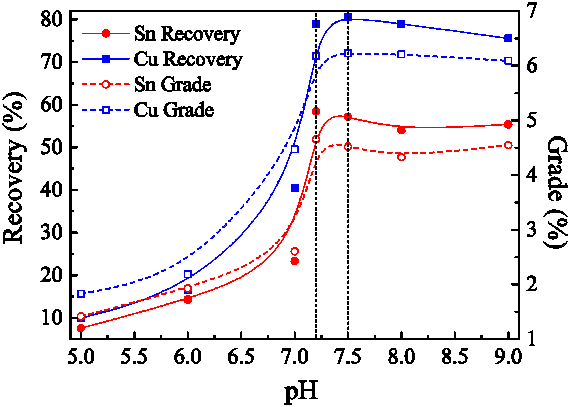
Figure 4. Flotation recovery and grade of Sn and Cu as a function of pulp pH value (carboxymethyl cellulose (CMC) 350 g/t; sodium fluorosilicate (SSF) 250 g/t; lead nitrate 200 g/t; Benzohydroxamic acid (BHA) 2000 g/t; Terpineol 25 g/t).